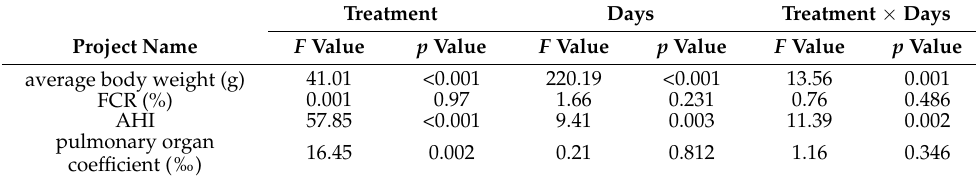
Table 4. Effects of AS on growth performance, organ index in broilers.